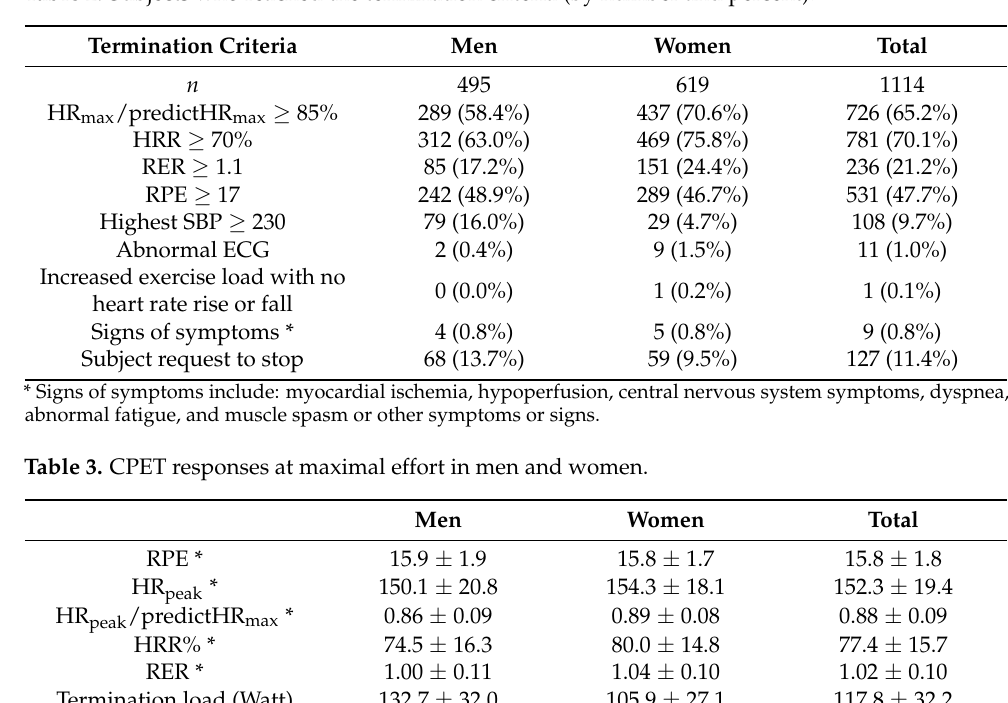
Table 2. Subjects who reached the termination criteria (by number and percent).